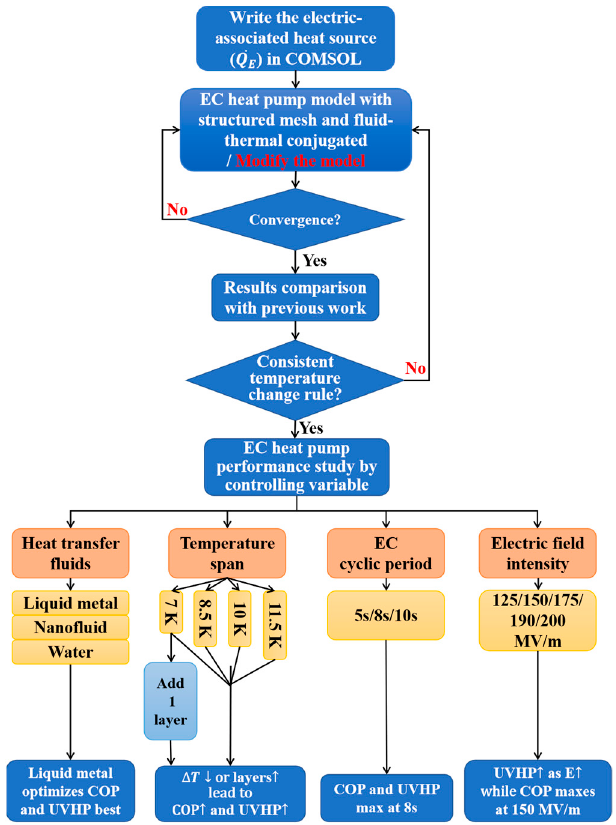
Figure 4. Flow chart of EC heat pump performance study.